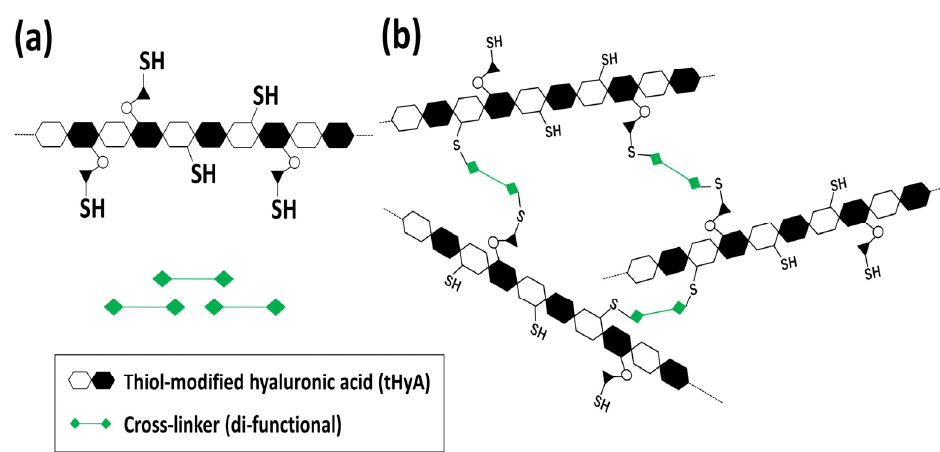
Figure 1. ( a ) Thiol modification of side chains of HyA, ( b ) cross-linking of tHyA by a di-functional cross-linker.